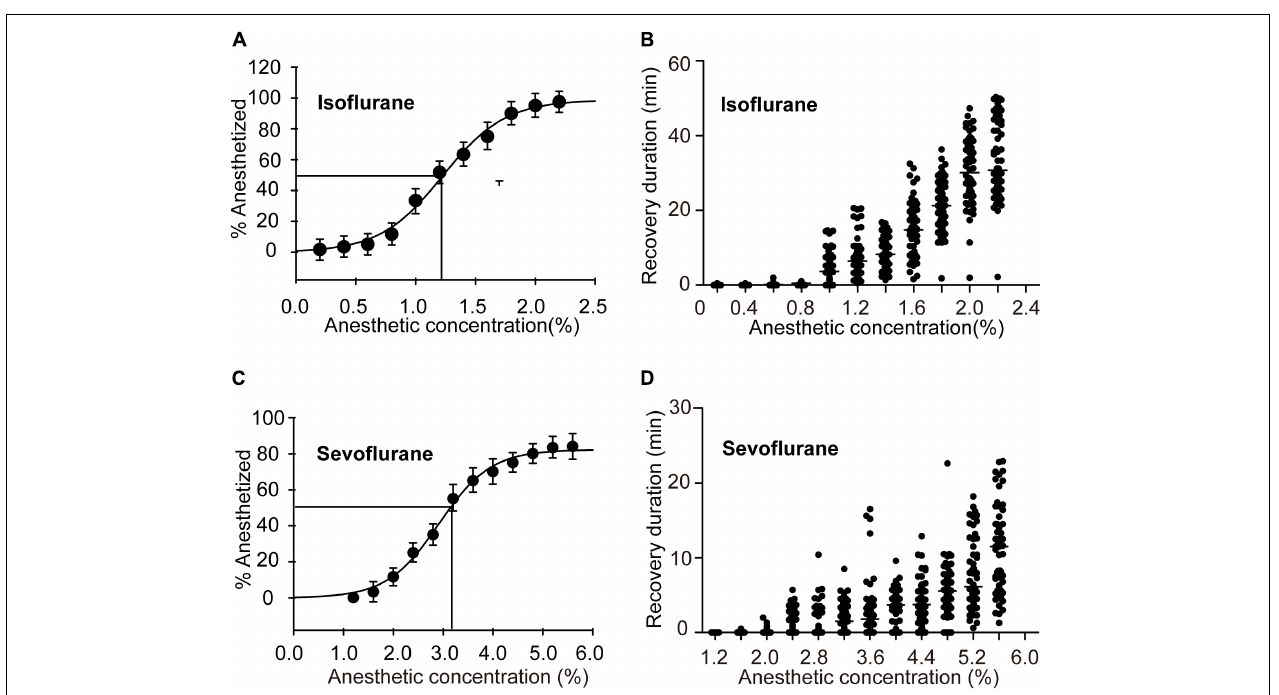
FIGURE 2 | Half-maximal effective concentrations (EC50s) after 30 min of exposure and recovery durations after exposure to graded concentrations of anesthetics. (A) EC50 and the graded concentration-response curve for the migratory locusts exposed to isoflurane ( n = 6 groups for each concentration, and 10 locusts in each group). (B) Recovery durations of the migratory locusts after exposure to the graded concentrations of isoflurane ( n = 60 for each dosage, Kruskal-Wallis test). (C) EC50 and the graded concentration-response curve for the migratory locusts with sevoflurane exposure ( n = 6 groups for each concentration, and 10 locusts in each group). (D) Recovery durations of the migratory locusts after the exposure to the graded concentrations of sevoflurane ( n = 60 for each dosage, Kruskal-Wallis test). Percentage of anesthetized locusts is shown as the mean ± SEM. One-way ANOVA is used for analyzing anesthesia response, and recovery durations of the migratory locusts from graded concentrations of anesthetics were analyzed by Kruskal-Wallis test.